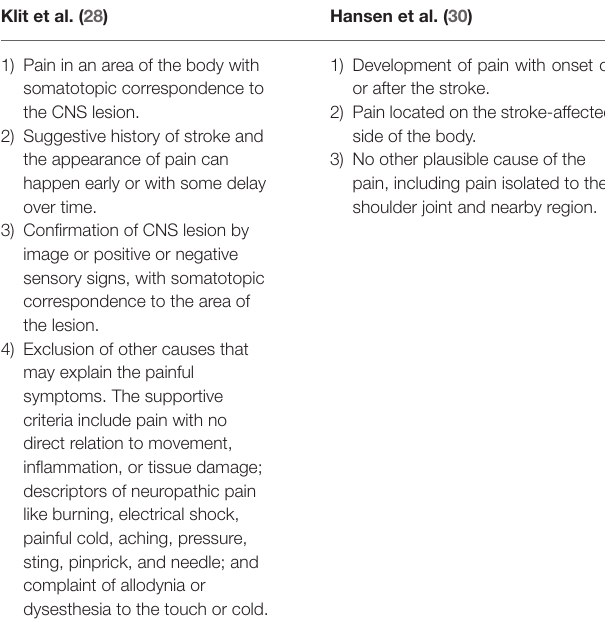
TABLE 1 | Diagnostic criteria for